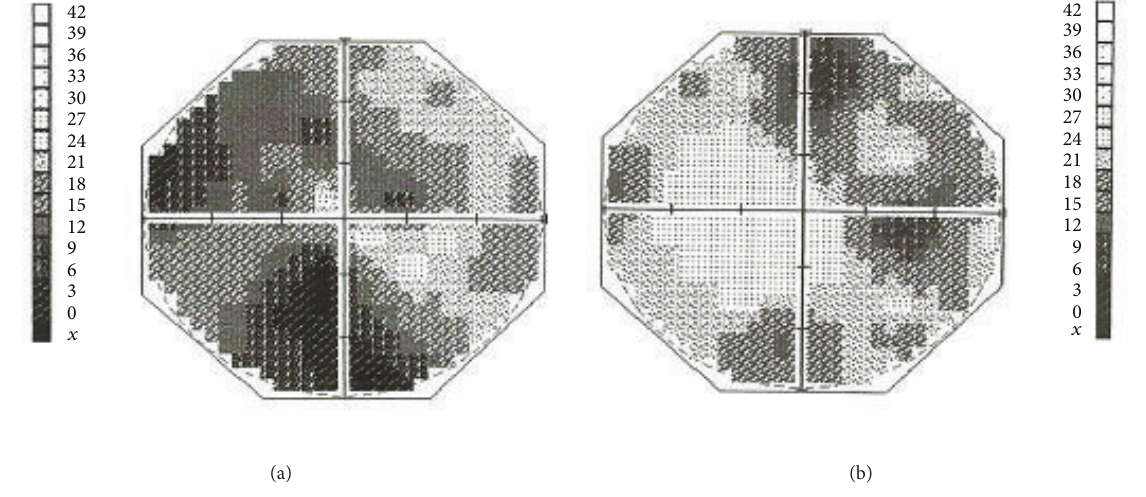
Figure 1: Central visual field defects: (a) the right eye; (b) the left